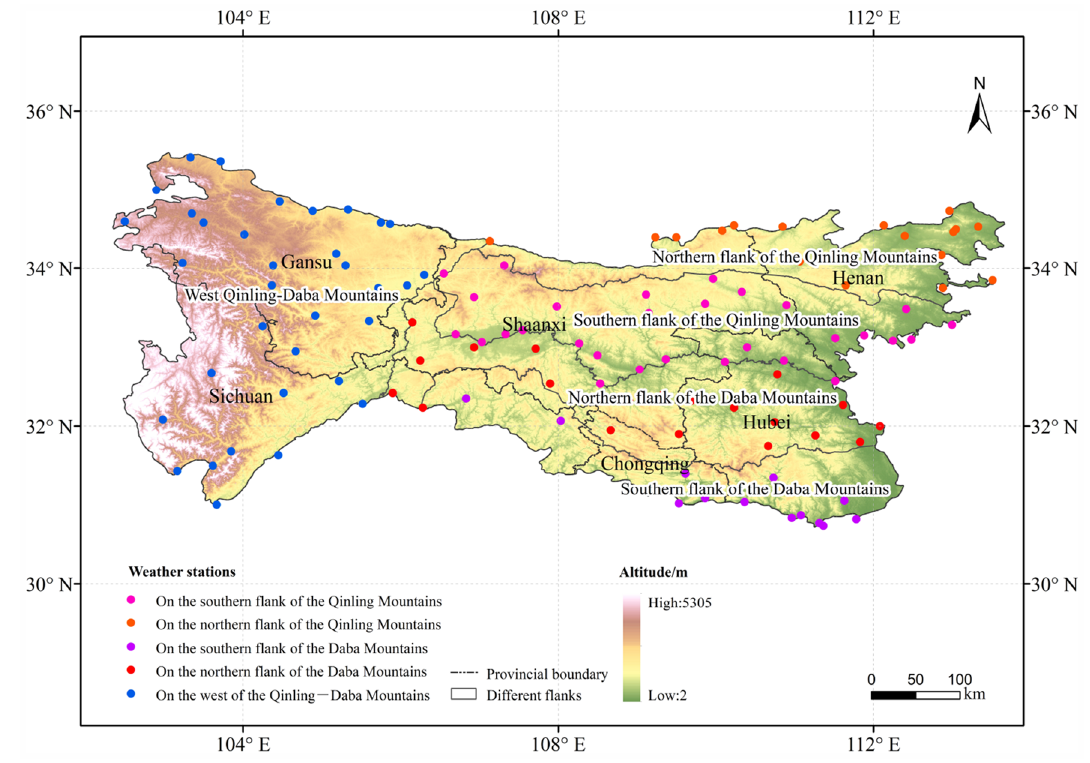
Figure 1. The study area and the spatial distribution of weather stations in the QDM. Pink dots represent weather stations on the southern flank of the Qinling Mountains (31), orange dots represent weather stations on the northern flank of the Qinling Mountains (20), purple dots represent weather stations on the southern flank of the Daba Mountains (13), red dots represent weather stations on the northern flank of the Daba Mountains (20), and blue dots represent weather stations on the western flank of the Qinling–Daba mountains (34). Notes: the map is created via the software ArcGIS 10.2 and the related research marks and words are added. The data of the map is from the site: https:// earth explo rer. usgs. gov/, https:// data. cma.